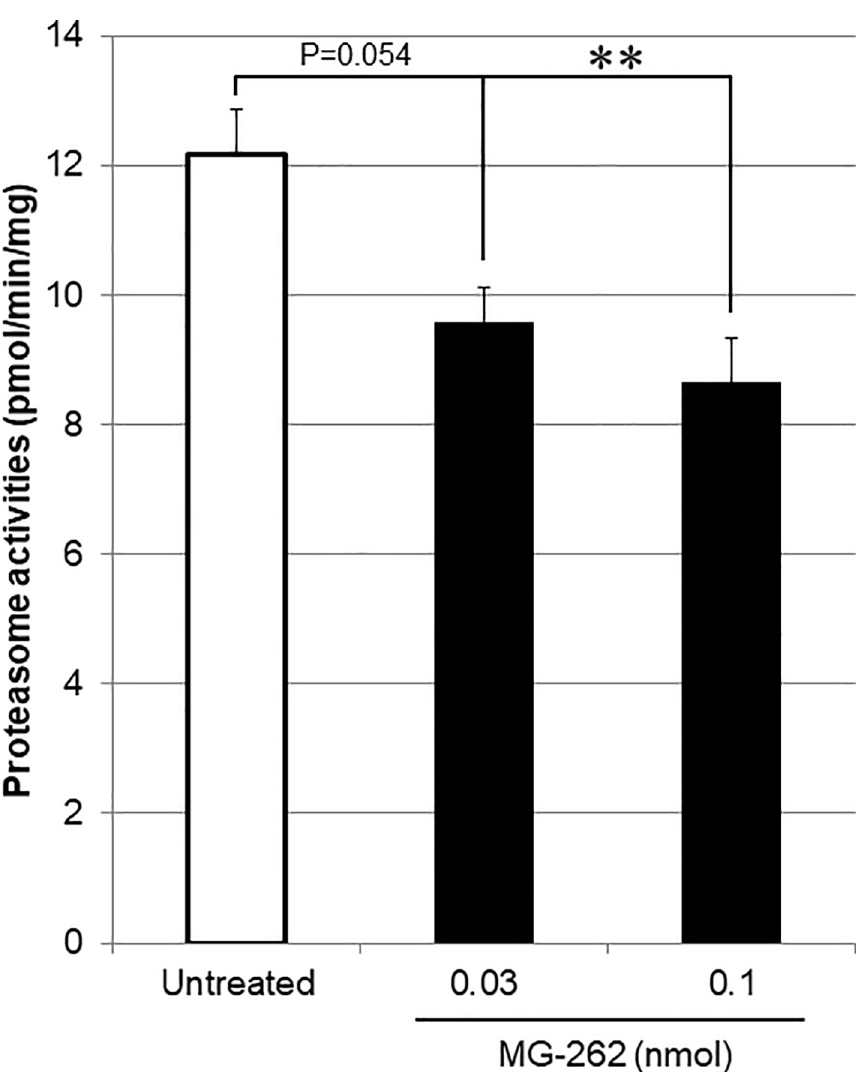
Fig 5. Inhibitory effects of MG-262 on retinal proteasome activity ex vivo . MG-262 (closed columns) was intravitreally injected at the doses of 0.03 and 0.1 (nmol/eye). For the control group (open column), the eyes were left untreated. Three days following intravitreal injection, the retina was isolated and proteasome activity in the retinal lysate was determined by a fluorometric method. Retinal proteasome activity was normalized to a total protein content in each retinal lysate. Each value represents the mean ± S.E.M. of 4 to 5 eyes from 2 to 3 animals. �� P < 0.01, by Tukey’s multiple comparison